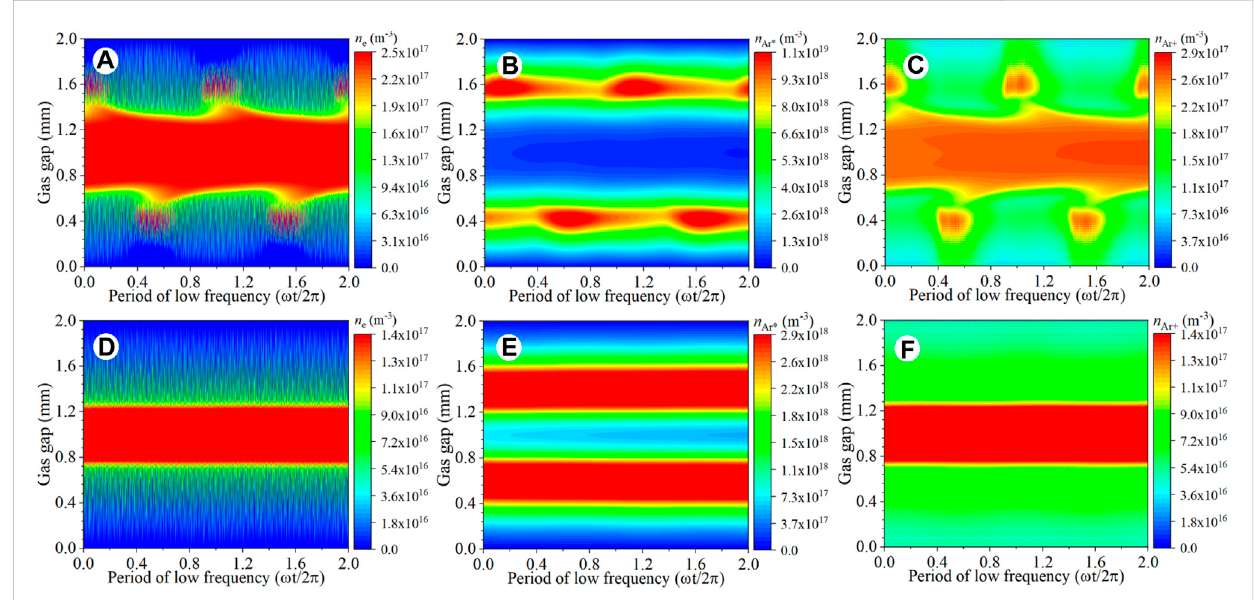
FIGURE 6 Spatial distribution of particle densities in two LF periods, for the LF-dominant mode with V L = 1300 V/ V H = 350 V (the upper row) and the DF- comparable mode with V L = 550 V/ V H = 350 V (the lower row), where the electron density is shown in (A, D) , the metastable state in (B, E) , and the ion in (C, F) .